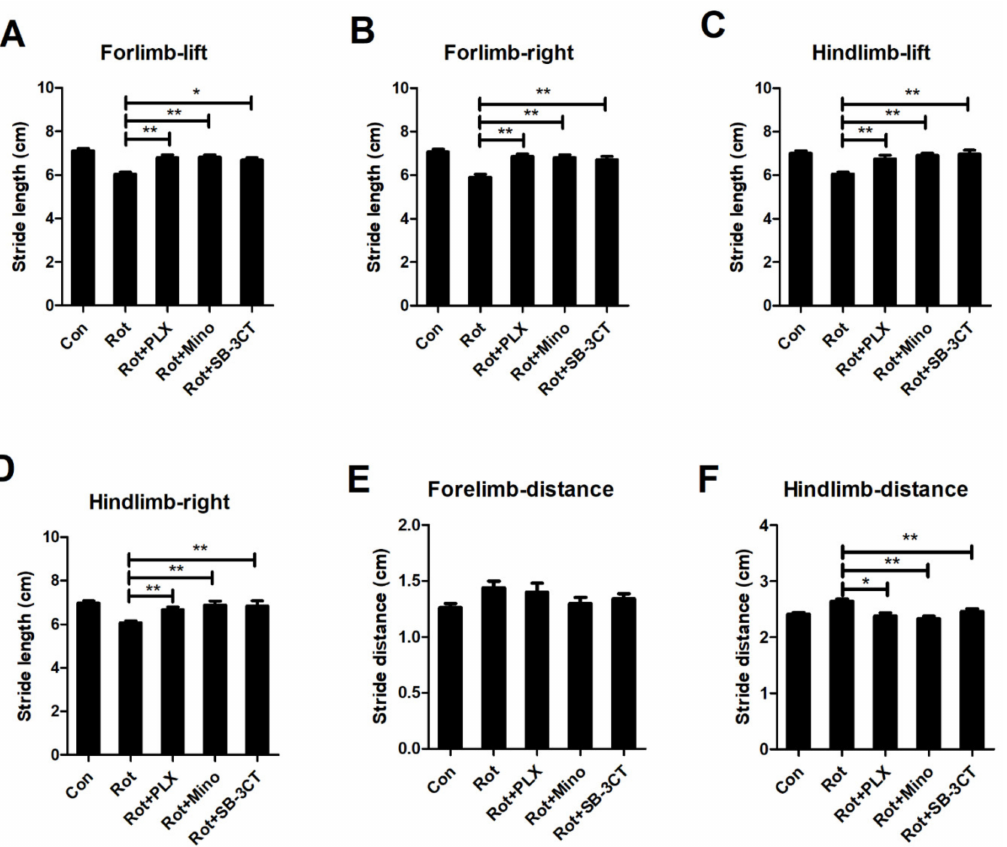
Figure 7. PLX3397, minocycline, and SB-3CT ameliorates rotenone-induced gait abnormality in mice. ( A – D ) The stride length between subsequent limb placements (stride length) in mice for each group. ( E , F ) The stride distance between limb placements in mice for each group. n = 11–12. * p < 0.05, ** p < 0.01. Con: vehicle-treated mice group; Rot: 1.5 mg/kg/d rotenone-treated mice group; Rot + PLX: 1.5 mg/kg/d rotenone + PLX3397-treated mice group; Rot + Mino: 1.5 mg/kg/d rotenone + minocycline-treated mice group; Rot + SB-3CT: 1.5 mg/kg/d rotenone + SB-3CT-treated mice